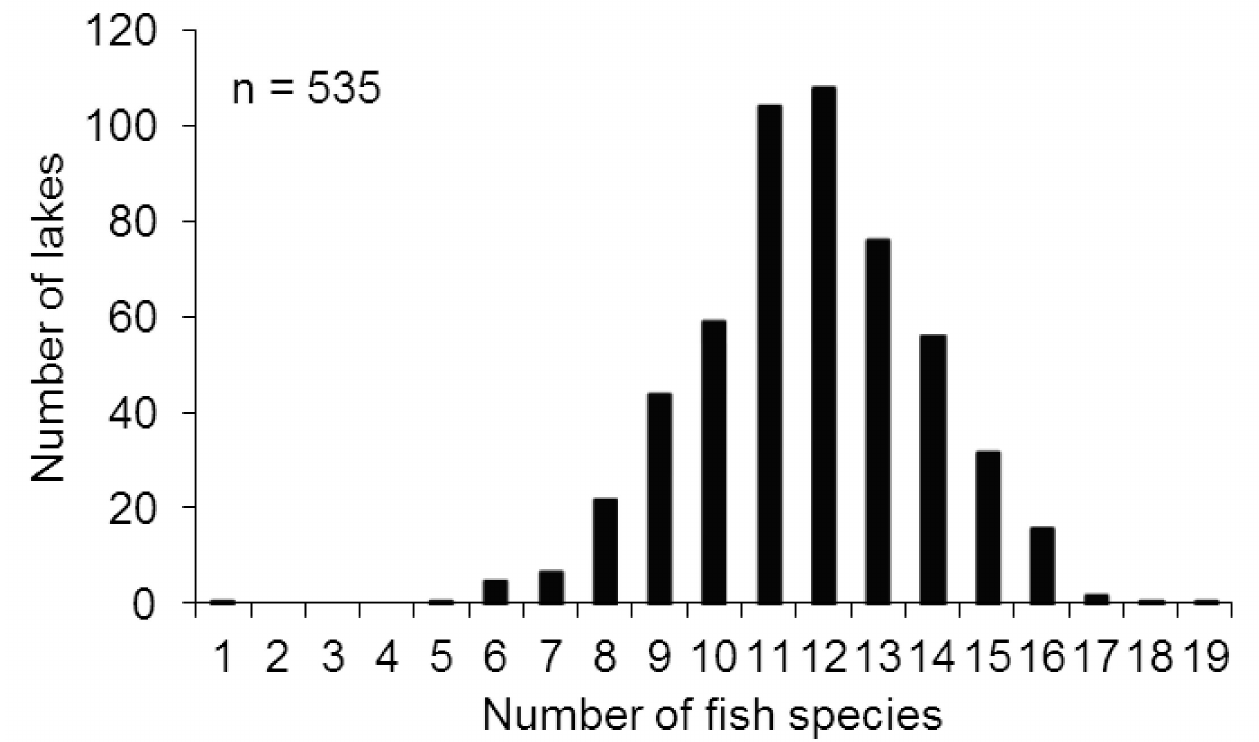
Figure 2. The number of fish species and the assigned number of lakes (in total n = 535 lakes).